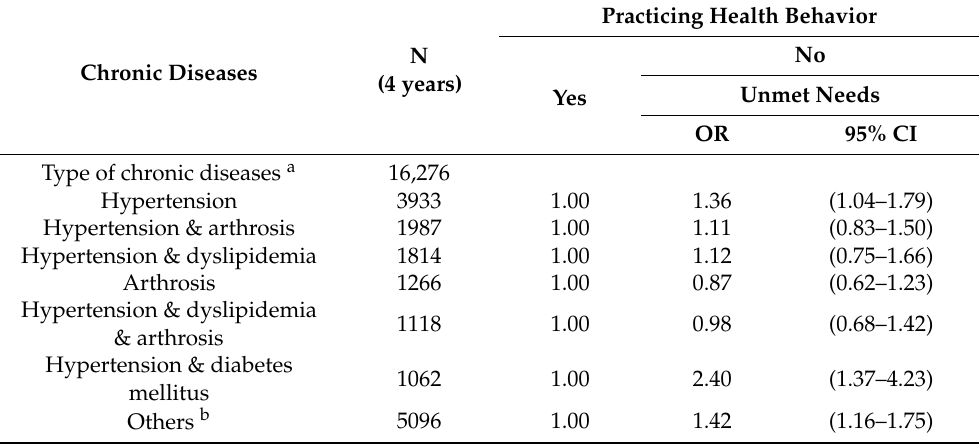
Table 4. Results of GEE analyzing the effect of practicing health behavior on unmet needs categorized by type of chronic diseases